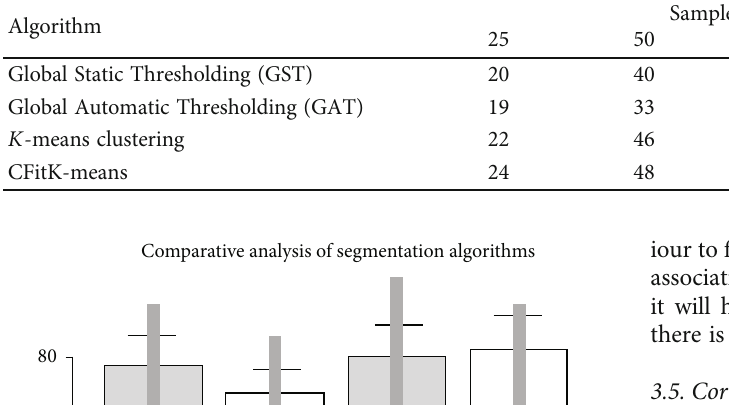
Table 1: Performance evaluation of segmentation algorithms in terms of IoU (intersection over union) score. Algorithm